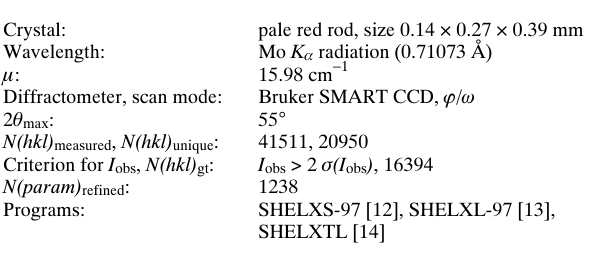
Table 1. Data collection and